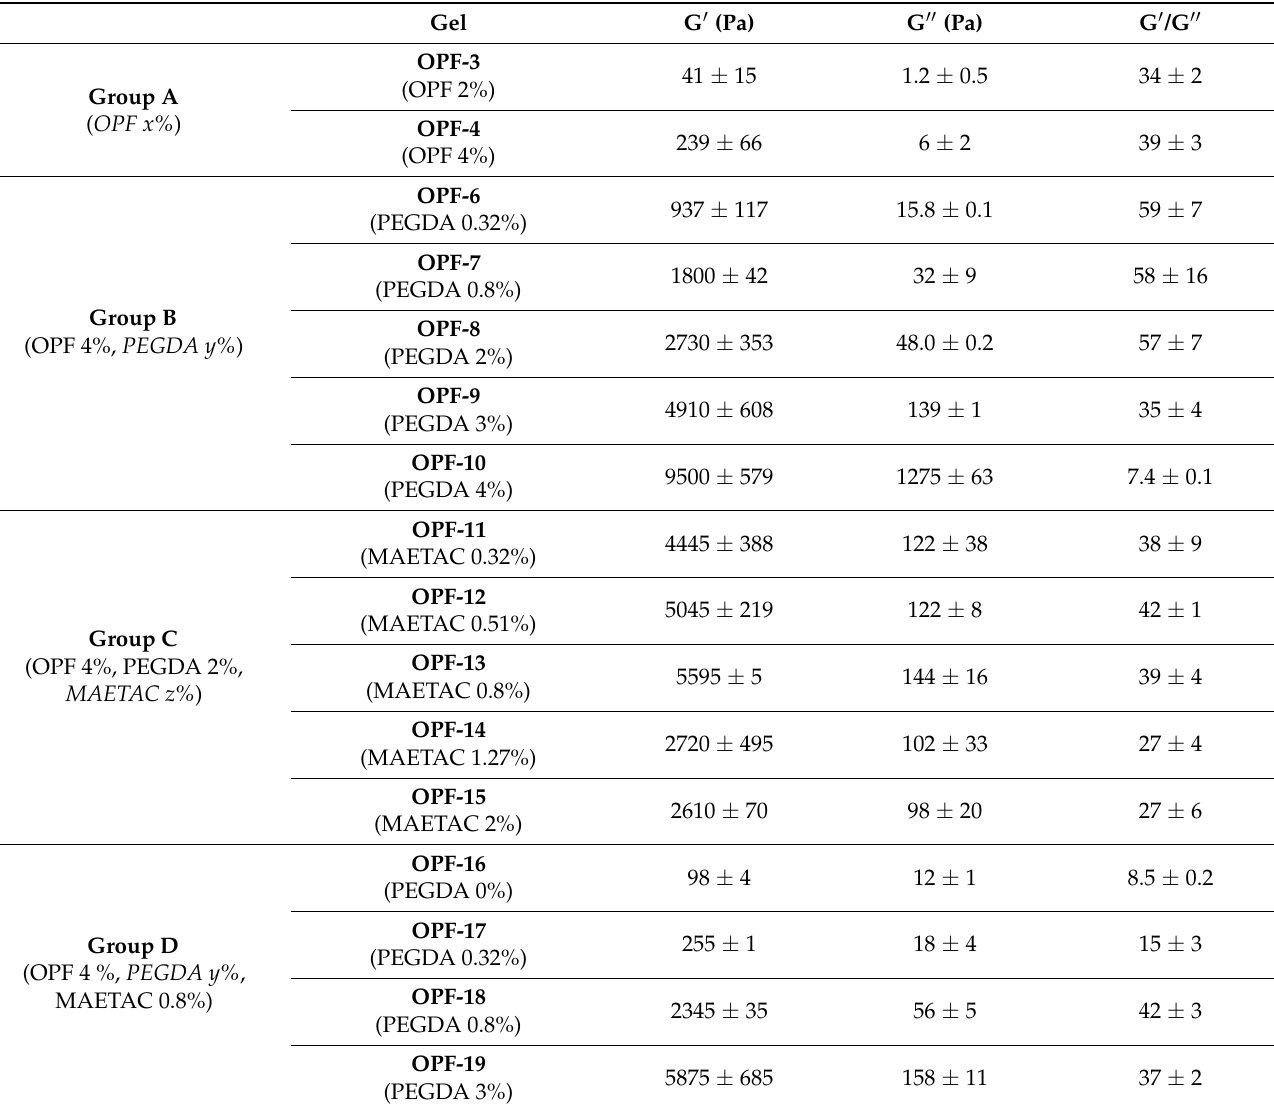
Table 2. Mean values of the storage modulus (G (cid:48) ), the loss modulus (G (cid:48)(cid:48) ), and the G (cid:48) /G (cid:48)(cid:48) ratio of OPF- based cryogels recorded at ω = 1 rad s − 1 . Cryogel compositions (wt. %) are shown in parentheses. The data are presented as mean ±